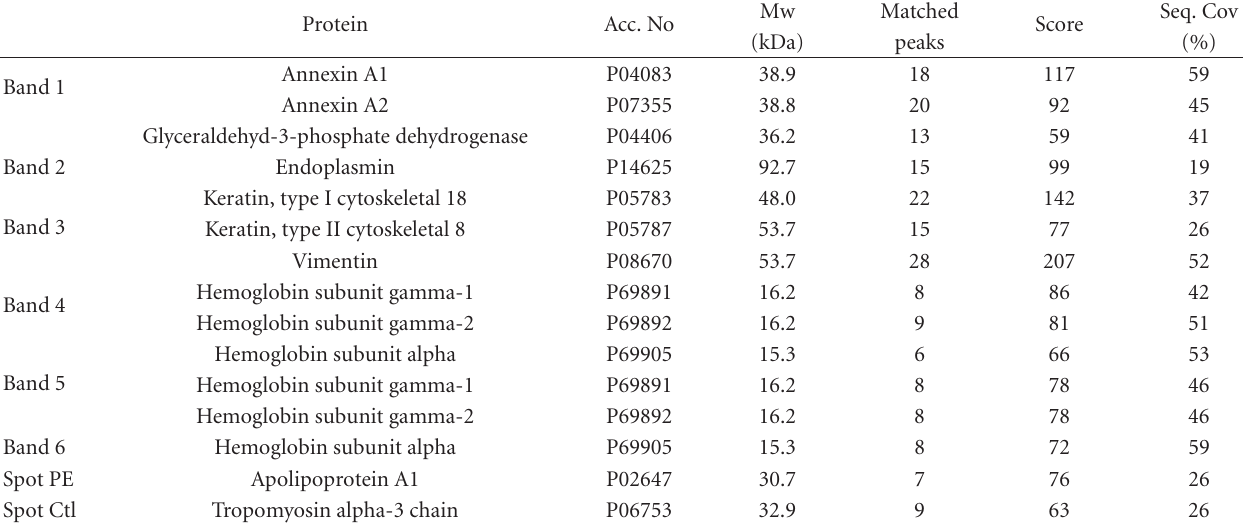
Figure 1: 1D-PAGE comparing solubilization and precipitation methods. (a) One-dimensional separation of proteins in PE placenta solubilized in Hepes bu ff er before and after centrifugation at 43 000 g. From left to right: Mw Precision standard marker, starting material (30 μ g), supernatant after centrifugation (30 μ g), and pellet after centrifugation. The gel was stained with Coomassie Brilliant blue. (b) One- dimensional separation of proteins in PE placenta solubilized in urea/CHAPS solution and (c) Hepes bu ff er. The lanes are from left to right: MW precision standard markers, starting material, and precipitations with acetone, acidified acetone, ethanol, dichloromethane/methanol, TCA, and TCA followed by ethanol wash. Bands indicated with numbers were identified by MALDI-TOF MS (Table 2). Table 2: Proteins identified using MALDI-TOF